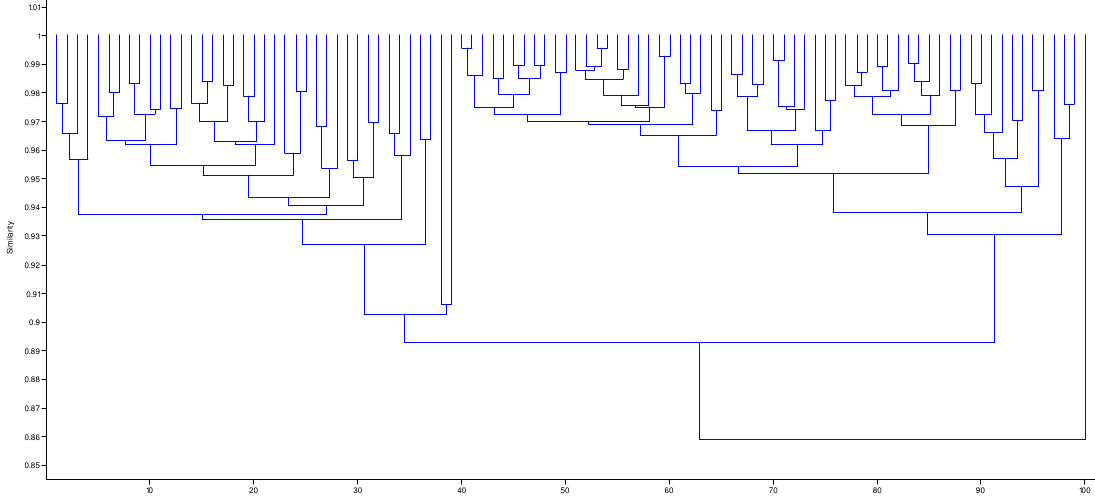
Fig. 9. Dendrogram showing similarity coefficient (85.8%) of the meristics of right side of wild and cultured samples of Clarias gariepinus employing the Bray-Curtis’s clustering algorithm *Blue color indicates wild population and green color indicates cultured population